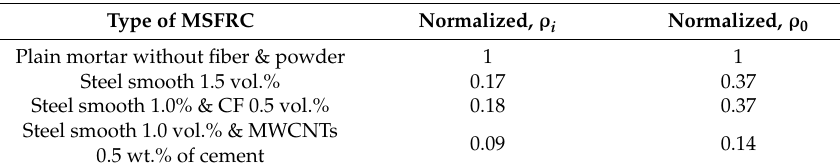
Table 5. Normalization of electrical resistivity of studied MSFRCs.